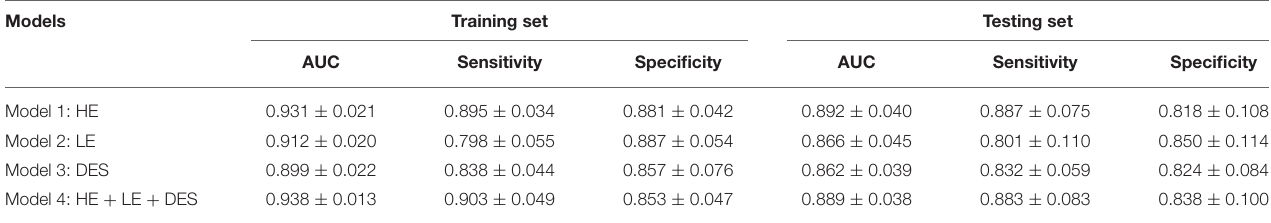
TABLE 3 | The results of leave-group-out cross-validation (LGOCV) analysis. Models Training set Testing set AUC Sensitivity Specificity AUC Sensitivity